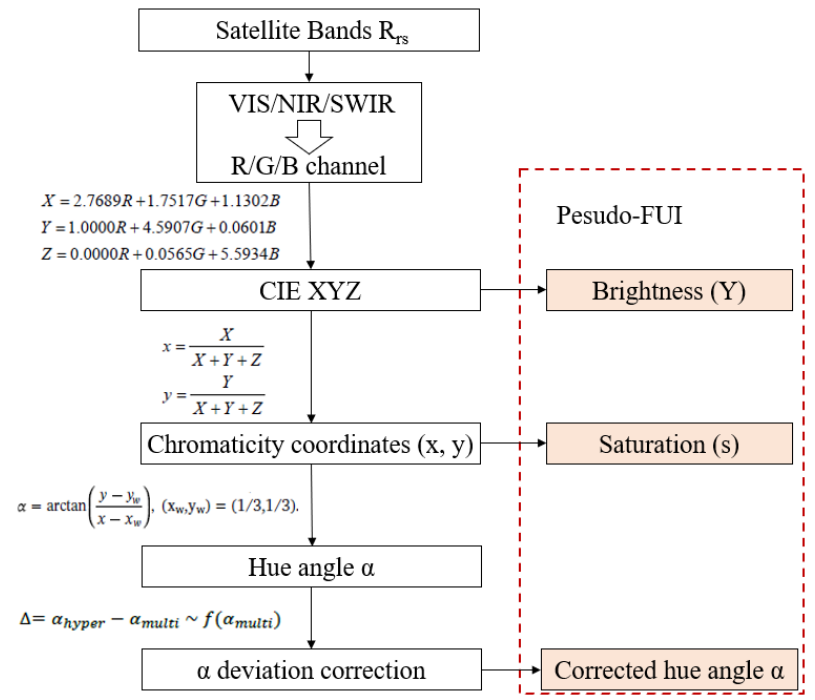
Figure 7. Flowchart of calculating P-FUI from satellite images.